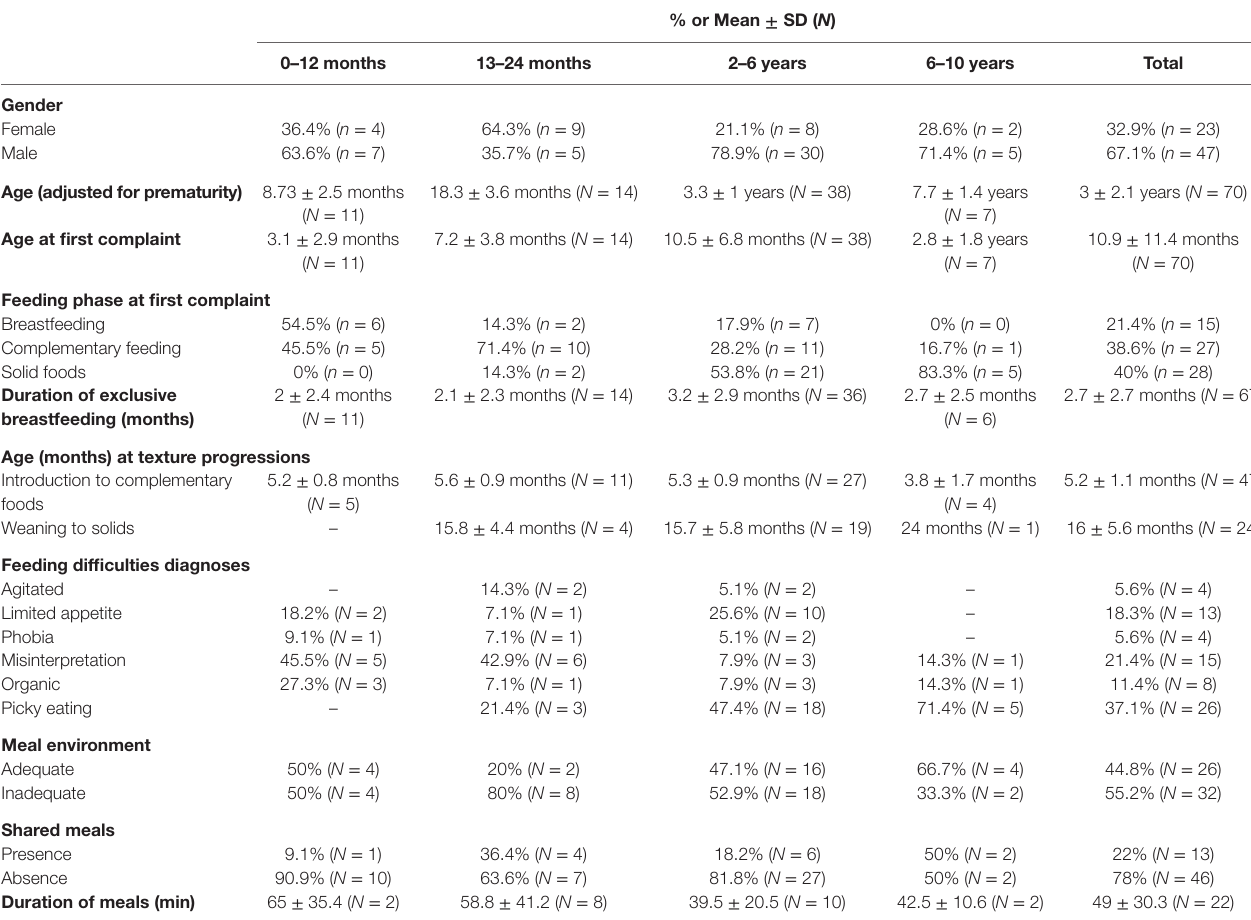
TaBle 1 | General characteristics of children according to age